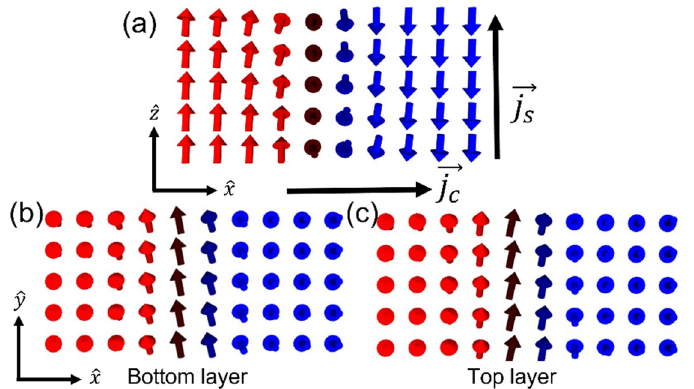
Figure 1. Schematic of a mixed Bloch/Néel domain wall without DMI. ( a ) Cross section view of the spin structure in the x–z plane of a thick ferromagnetic film with perpendicular anisotropy showing the central Bloch component with twisting near the surfaces indicative of the formation of Néel caps. The direction of charge and spin currents are noted by 𝚥 (cid:3030) (cid:4652)(cid:4652)⃗ and 𝚥 (cid:3046) (cid:4652)(cid:4652)⃗ , respectively, while the spin polarization is orthogonal to both 𝚥 (cid:3030) (cid:4652)(cid:4652)⃗ and 𝚥 (cid:3046) (cid:4652)(cid:4652)⃗ . ( b , c ) Bottom and top surfaces of the film, respectively, in the x–y planes demonstrating the clear deviation from a pure Bloch structure and the varied chirality of the Néel caps at each surface.